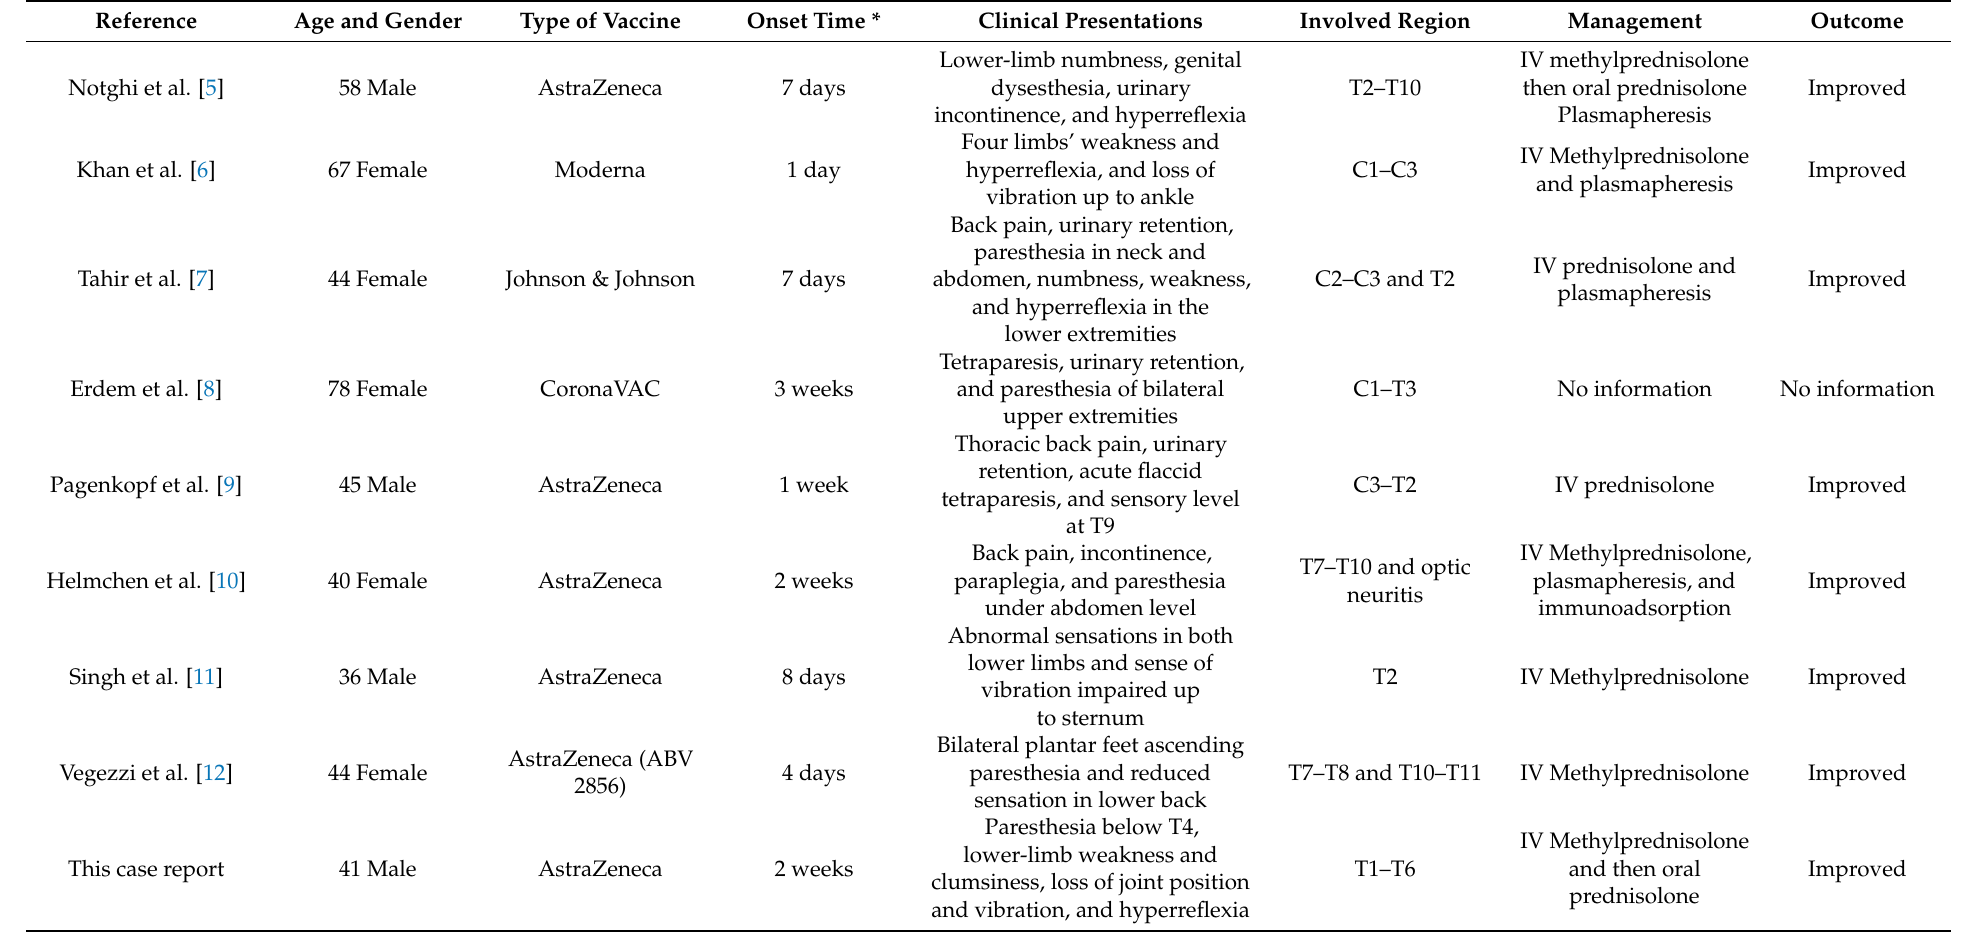
Table 1. Summary of the published case reports of SARS-CoV-2 vaccination-induced transverse myelitis in the